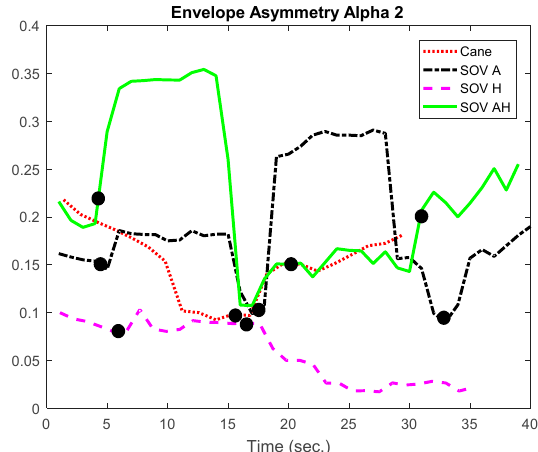
Figure 21. The envelopes of the alpha2 asymmetries for a late-blind user.